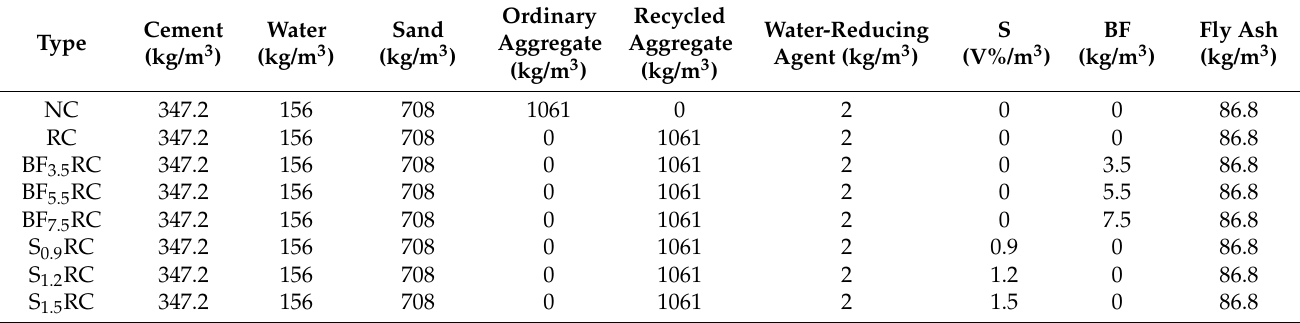
Table 10. The mixed proportion of